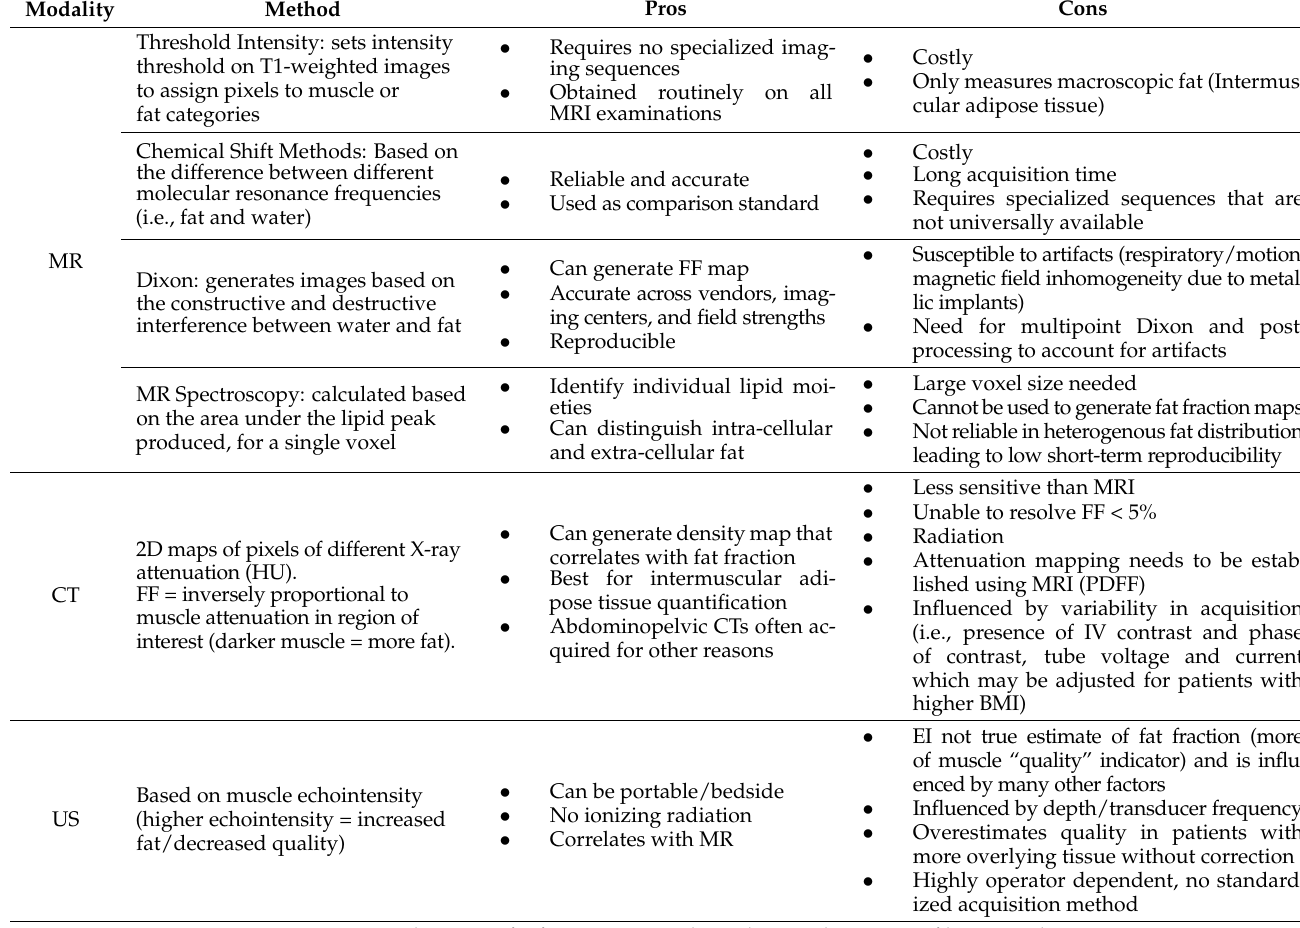
Table 1. Muscle fat infiltration estimation by